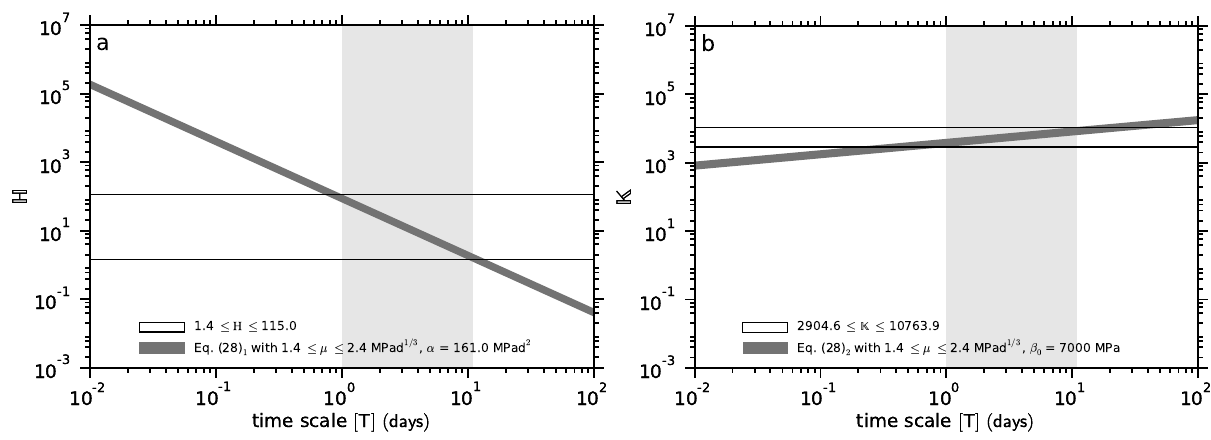
Fig. 5. Change of the dimensionless numbers H and K of Eq. (28) as functions of the time scale and the parameters from Table 2.